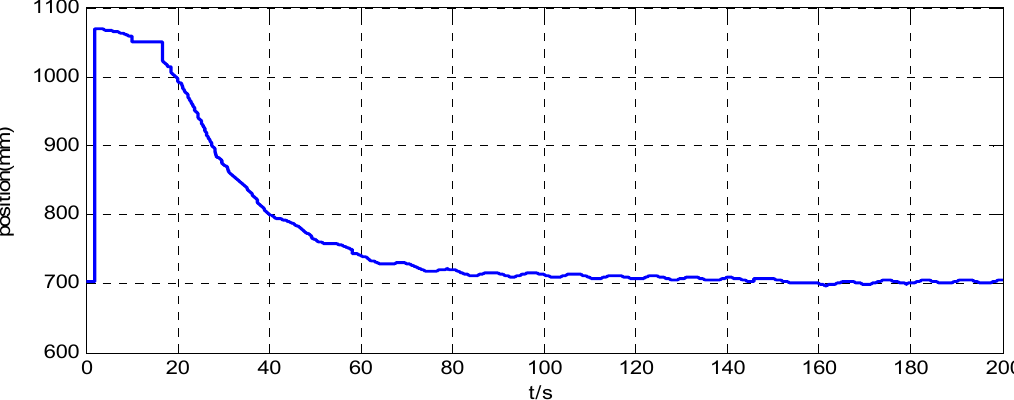
Figure 14. Position along the x-axis of the simulator when x ( 0 ) = 1036mm.